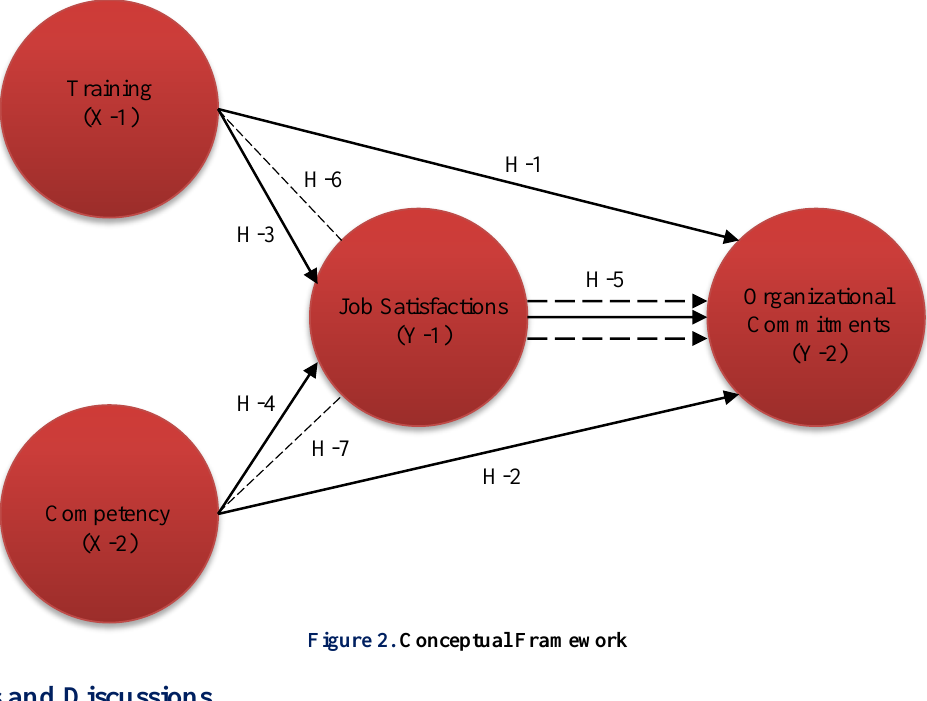
Figure 2. Conceptual